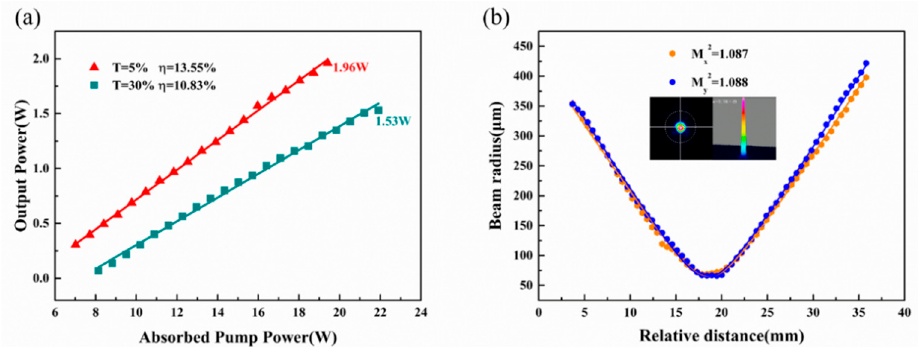
Figure 9. The laser spectra of the Yb:LuAG SCF with the central wavelengths of 1032 ( a ) and 1047 nm ( b ).